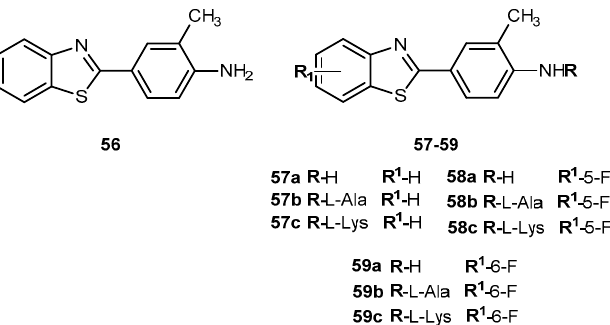
Figure 26. Structure of 2-(4-aminophenyl)benzothiazole 56 and its amino acid prodrugs 57a – c , 58a – c , and 59a – c .